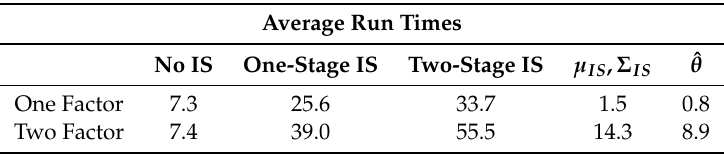
Table 2. This table reports summary statistics—in seconds, and across 100 randomly selected parameter sets—for total run time (first three columns), time required to estimate the first-stage IS parameters (fourth column) and time required to fit the second-stage polynomial approximation to ˆ θ (final column). Average Run Times No IS One-Stage IS Two-Stage IS µ IS , Σ